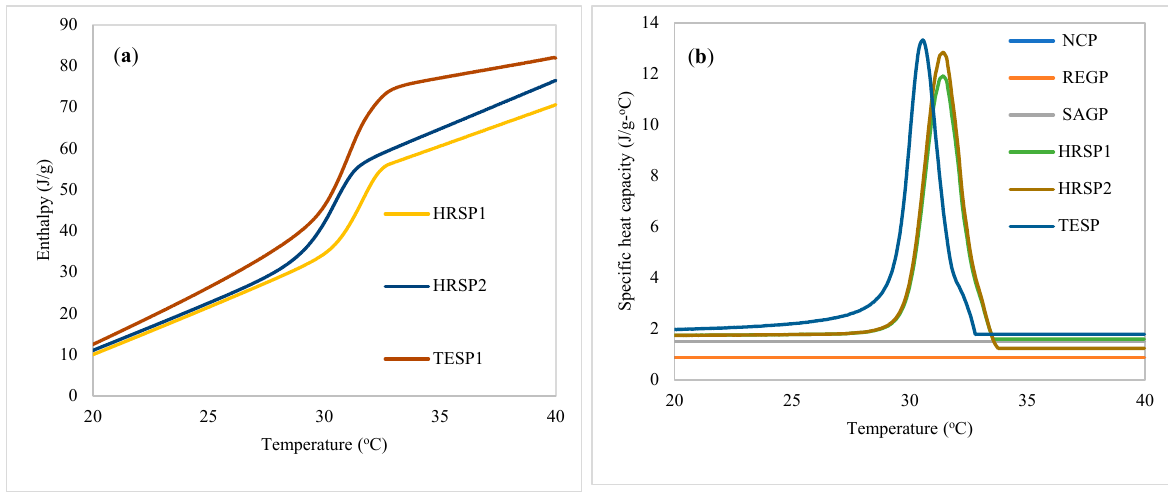
Figure 6. ( a ) Enthalpy and ( b ) specific heat capacity vs. temperature curves of the developed panels. Table 4. Single-glazed aluminum-framed windows.